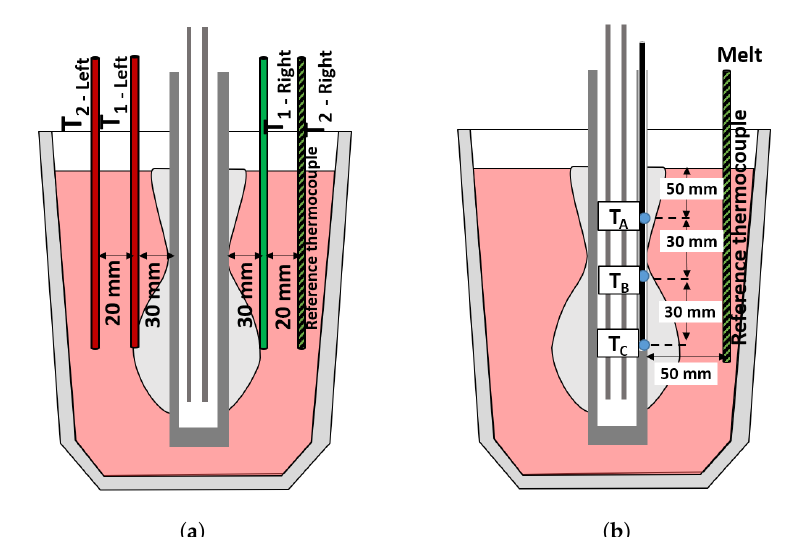
Figure 2. Experimental setup for the measurement of the ( a ) horizontal and ( b ) vertical temperature gradient needed for the construction of the numerical model. Both trials were conducted without rotation and with a cooling gas flow of 50 L · min − 1